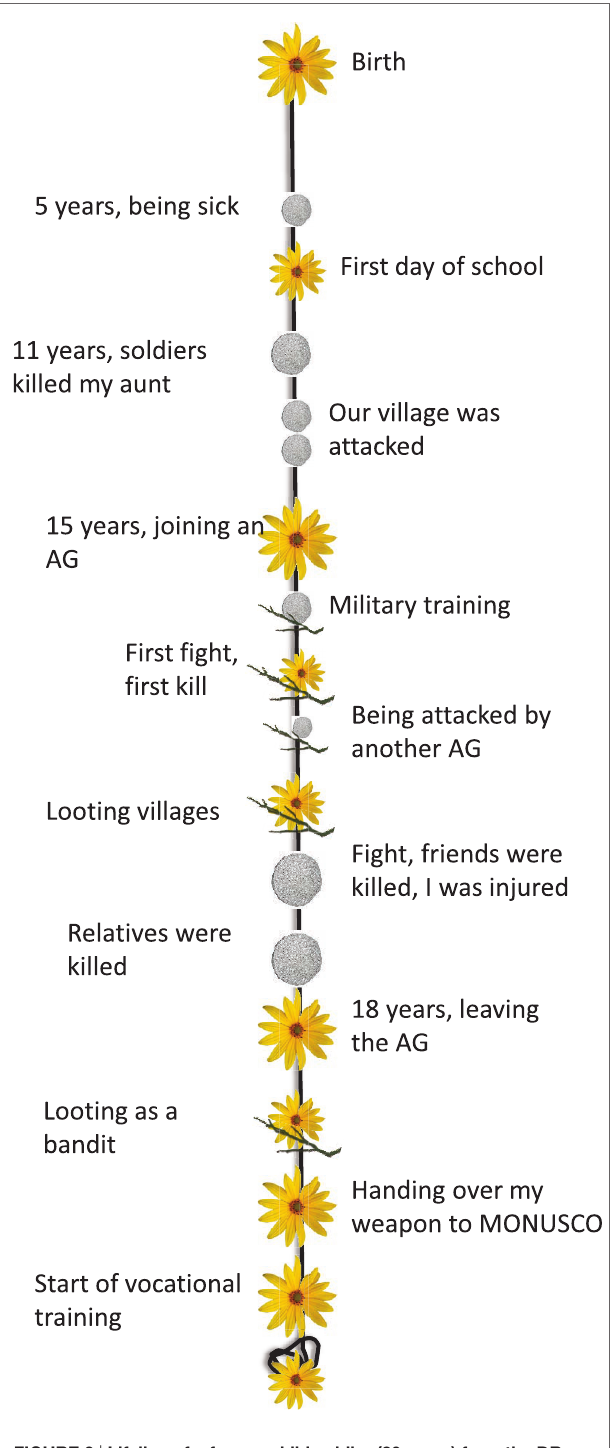
Figure 3 | Lifeline of a former child soldier (20 years) from the dr Congo . AG, armed group; MONUSCO, United Nations Mission in the